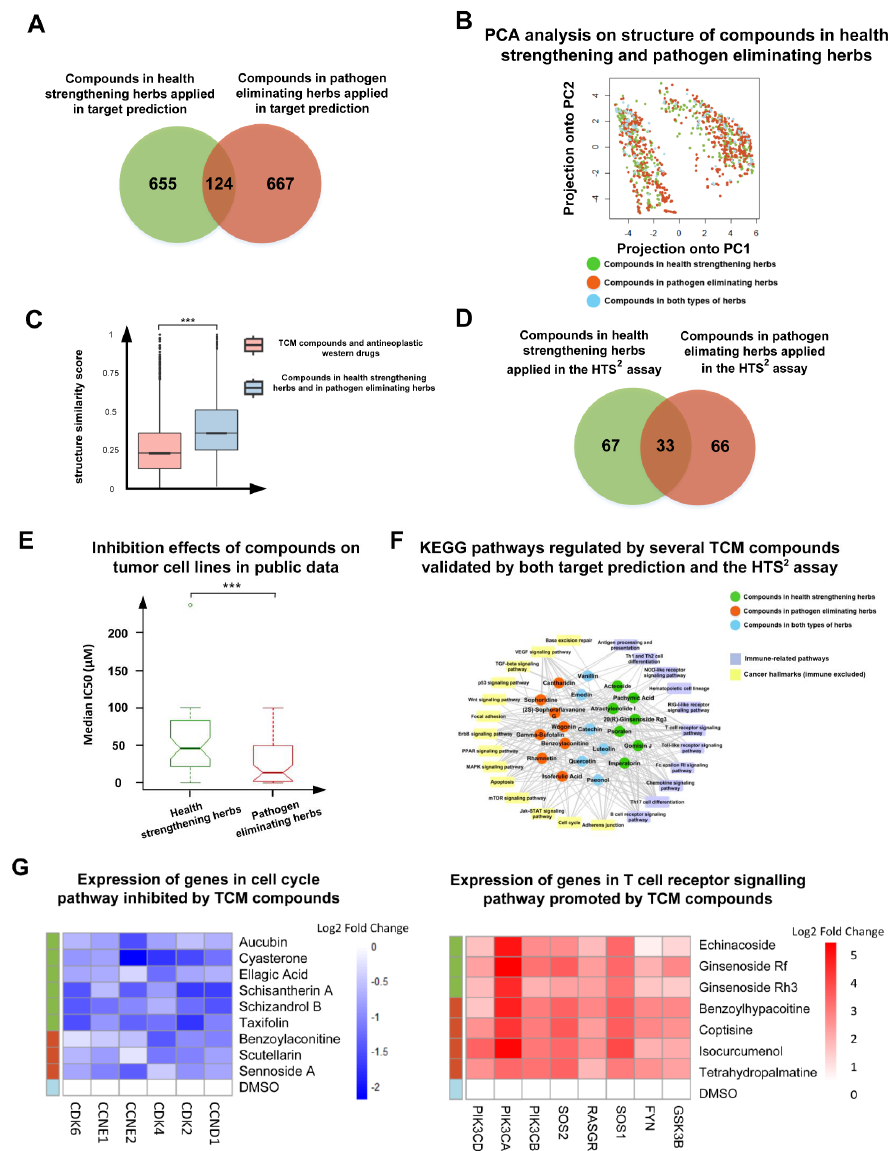
Figure 2. An overview of types of TCM applied in the research on their structures, inhibitory effects on tumor cells, and regulated bioactivities, based on public data, target prediction, and the HTS 2 assay. ( A ) The number of compounds in the two types of TCM herbs in cancer treatment applied in the target prediction. ( B ) PCA analysis on structure of compounds in the two types of herbs in cancer treatment. ( C ) The structure similarity comparison between the compounds from health-strengthening herbs and pathogen-eliminating herbs and that between the TCM compounds and antineoplastic Western drugs via Tanimoto coefficients. Data represent median ± interquartile range. Statistical analysis was performed using a Kolmogorov–Smirnov (KS) test. *** p < 0.001. ( D ) The number of compounds from the two types of TCM herbs applied in the HTS 2 . ( E ) The inhibitory effects of compounds in the two types of herbs on proliferation of tumor cell lines in public bioactivity databases. Data represent median ± interquartile range. Statistical analysis was performed using a Wilcoxon rank sum test. *** p < 0.001. ( F ) The regulated immune and cancer hallmarks (immune-excluded) pathways of several TCM compounds supported using target prediction and the HTS 2 assay. ( G ) Expression data of several genes in the cell cycle and T cell receptor signaling pathways after TCM compound